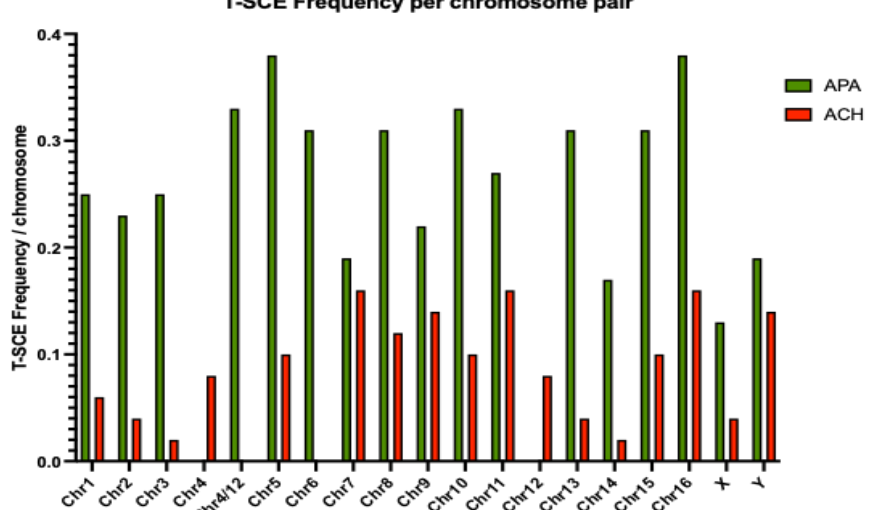
Figure 8. Comparison of the T-SCE frequencies per chromosome observed in A. paniscus (green) and